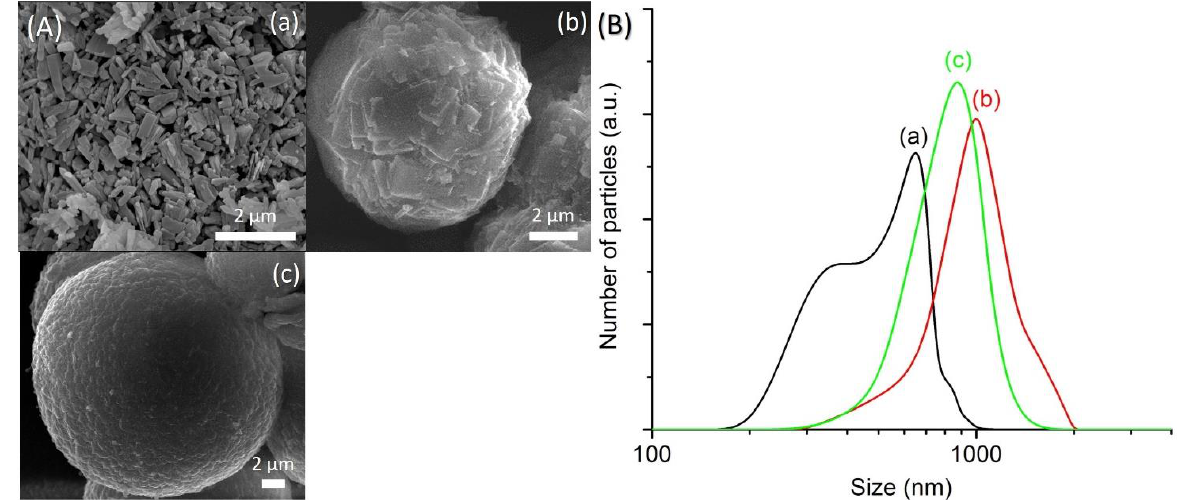
Figure 4. ( A ) FESEM images and ( B ) particle size distributions of ( a ) SH4 ( w = 2.5), ( b ) SH7 ( w = 3.0) and ( c ) SH8 ( w = 3.5) where the solid products were prepared using precursor hydrogels with a molar composition of 1Al 2 O 3 : w P 2 O 5 :2.5[bzmIm] 2 O:180H 2 O:0.47SiO 2 heated at 150 °C for 10 h.